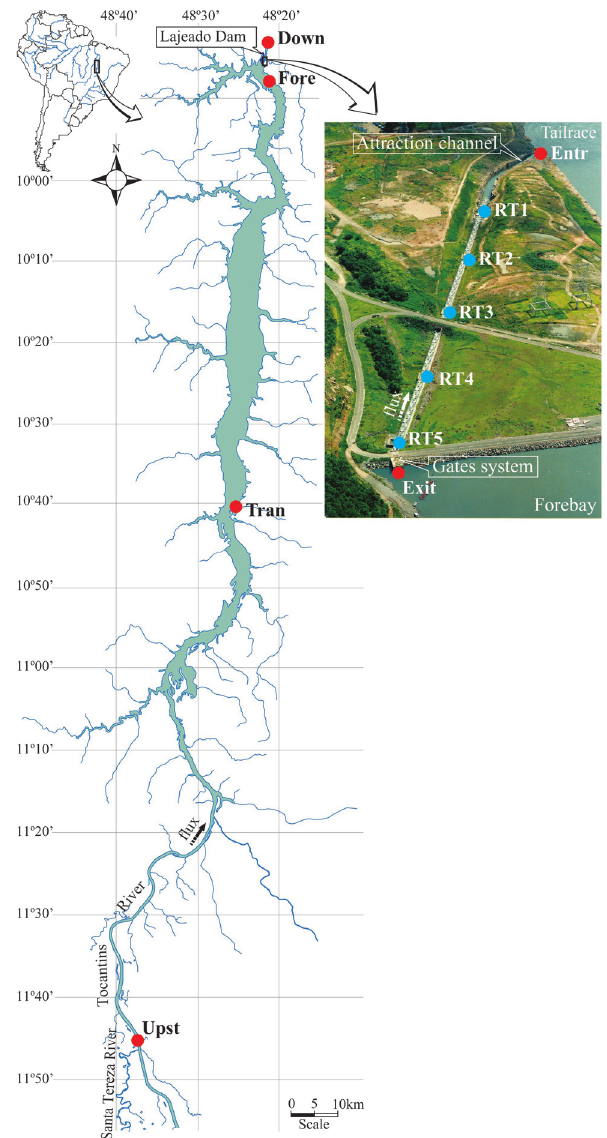
Fig. 1. Map showing the monitoring sites in the Lajeado Reservoir and in the fish ladder (picture in detail). (Reservoir: Down = downstream, Fore = forebay, Tran = reservoir transition, and Upst = upstream; fish ladder: Entr = entrance and exit of the fish ladder; RT =